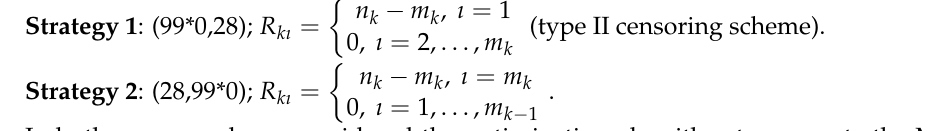
Figure 5. MCMC trace for results of Bayesian estimation of model for complete Bladder data for the last two parameters.